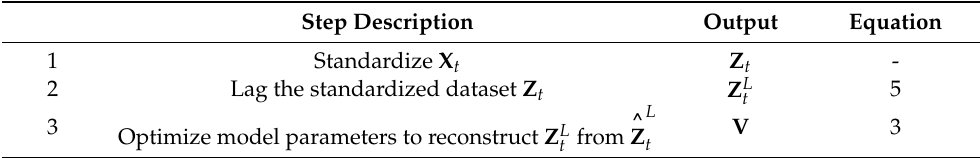
Table 3. Model derivation algorithm for dPCA.